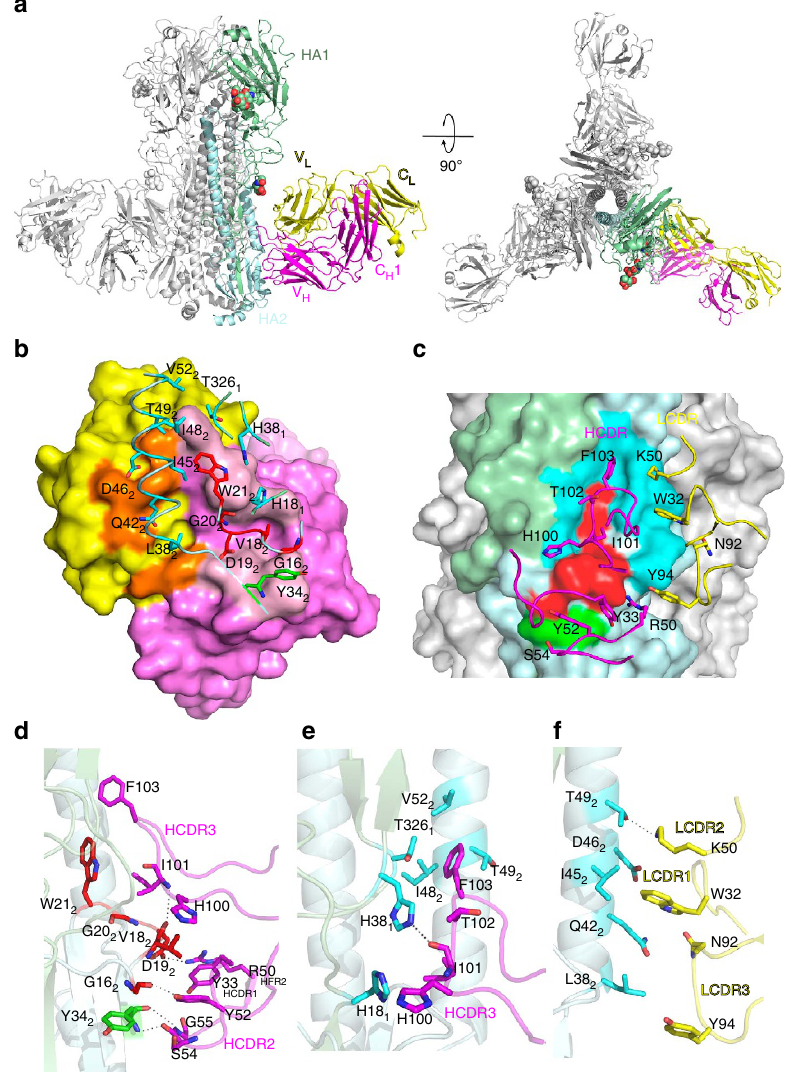
Figure 3 | Structure of the 3E1 Fab–CA09 HA complex. ( a ) The overall structure of the 3E1 Fab–CA09 HA complex is shown in cartoon representation from the side view and top view. HA1 and HA2 are coloured in pale green and pale cyan, respectively. The heavy chain and light chain of 3E1 Fab are coloured in magenta and yellow, respectively. The glycans are shown with spheres. 3E1 Fab binds to the stem region of HA. ( b ) The interaction interface between 3E1 Fab and HA looking down at the Fab (paratope). The Fab is shown in surface representation, with heavy chain in violet, and the HA in cartoon. The residues of the heavy chain and light chain at the antigen-binding site coloured in light pink and orange, respectively. The key residues of the epitope are shown with side chains: these of HA1 are denoted with a subscript 1 and these of HA2 with a subscript 2, and these of the fusion peptide are coloured in red, these of the F subdomain in cyan, and these of the b -strand in green. ( c ) The interaction interface between 3E1 Fab and HA looking down at the HA (epitope). The HA is shown in surface representation and the Fab in cartoon. The key residues of the antigen-binding site are shown with side chains. ( d – f ) Specific interactions between the fusion peptide (red) and b -strand (green) and the HCDR loops (magenta) ( d ), between the F subdomain (cyan) and the HCDR3 loop (magenta) ( e ) and between the F subdomain (cyan) and the LCDR loops (yellow) ( f ). The key residues are shown with side